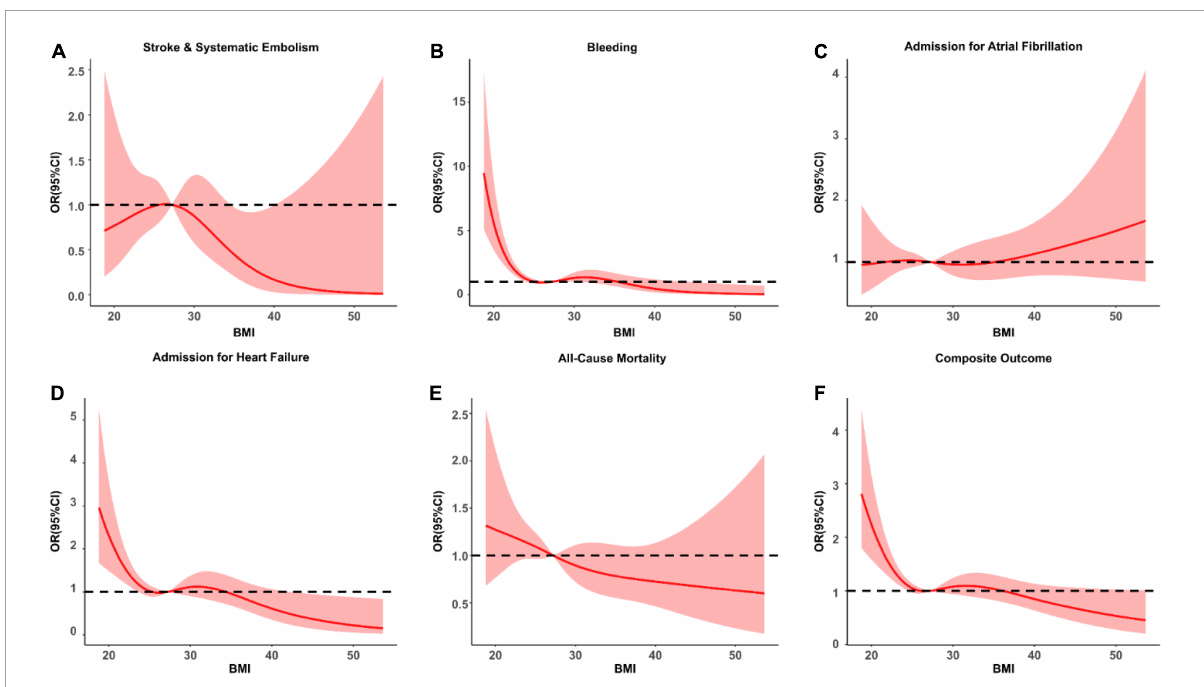
FIGURE2 The hazard ratio (95% CI) BMI as a continuous variable for clinical outcomes [ (A) stroke and systematic embolism; (B) bleeding; (C) admission for atrial fibrillation; (D) admission for heart failure; (E) all-cause mortality; (F) composite outcome]. The solid red line is the multivariate adjusted odds ratio, and the pink shade represents the 95% confidence interval. Unrelated reference lines are represented by dotted lines.